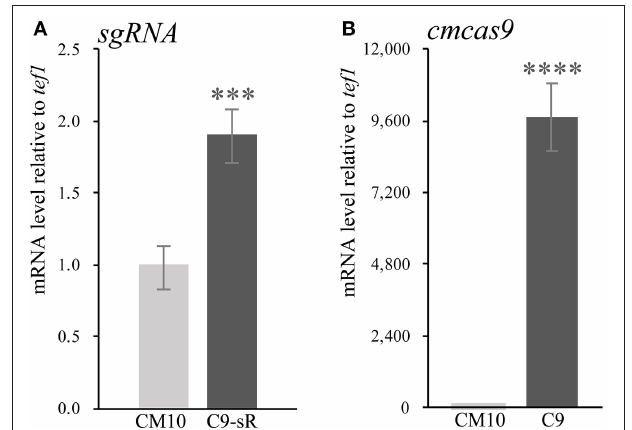
FIGURE 2 | The qPCR experiments were carried out in biological triplicate. Data are represented as the mean ± SEM ( n = 9). Statistical analyses were performed using t -tests compared with wild-type “CM10” (*** p < 0.001, **** p < 0.0001). (A) The expression level of sgRNA in the transformant C. militaris C9-sR ( C. militaris: : blpR - cmcas9 - gfp-HH-sgRNA-HDV ). (B) The expression level of Cas9 in the transformant C. militaris C9 ( C. militaris: : blpR - cmcas9 - gfp